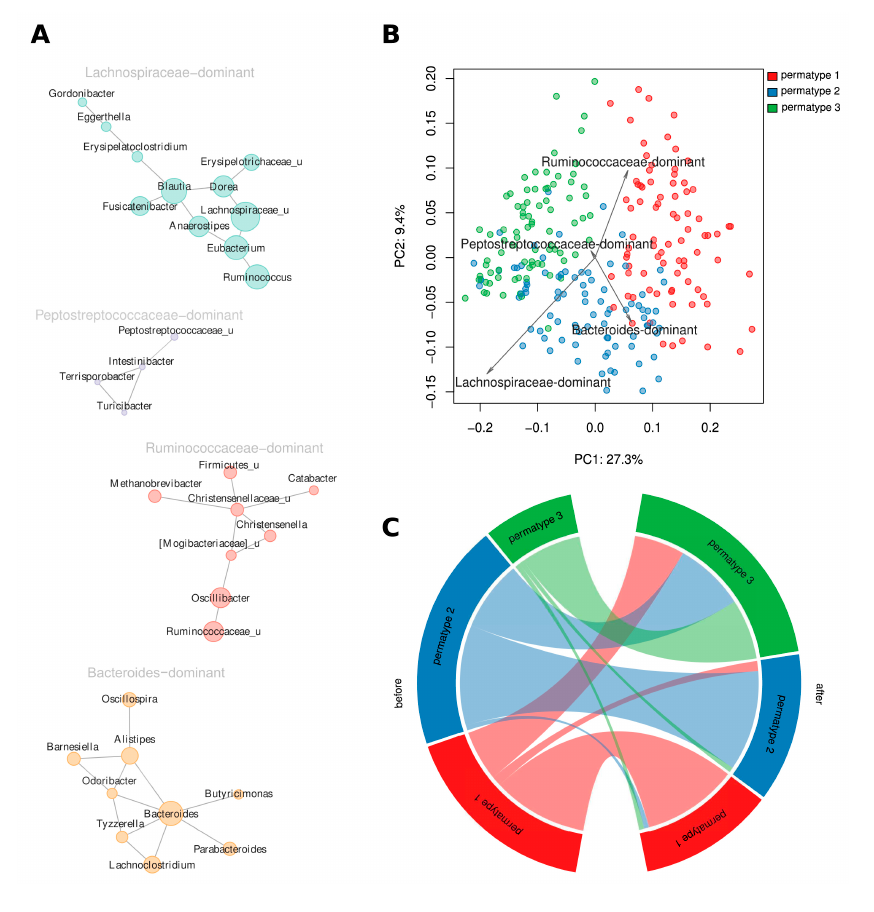
Figure 4. Cluster analysis for microbial genera and samples. ( A ) Cooperatives of microbial genera. Size of the vertices is proportional to the average relative abundance of the genera in all metagenomes. Postfix “_u” denotes all unclassified genera from the respective family. ( B ) Links between cooperatives and permatypes (principal coordinates analysis [PCoA] using generalized UniFrac metric). ( C ) Changes in distribution of the participants across permatypes after following the dietary